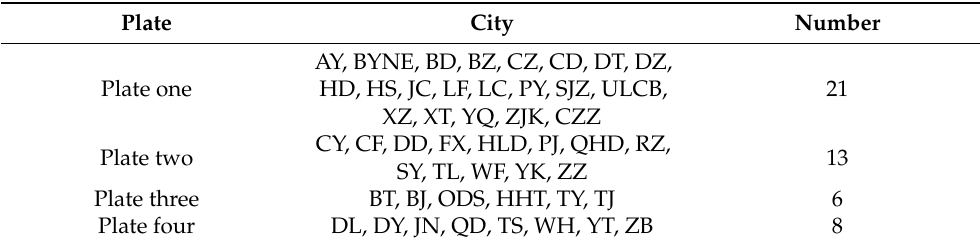
Table 5. Cluster analysis for green economic development.